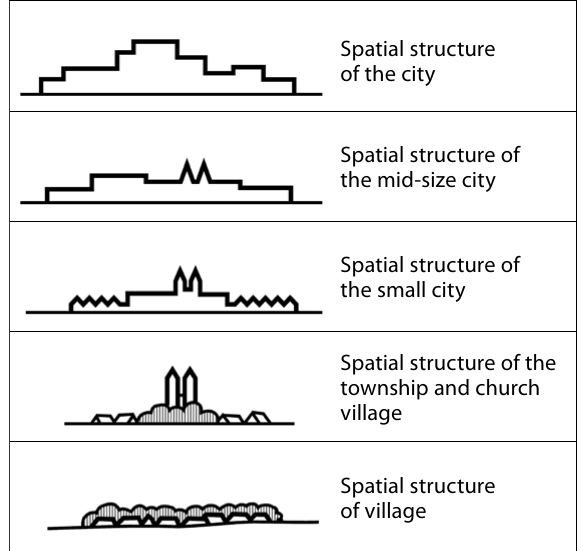
fig. 3. Models of the spatial structure of the lithuanian